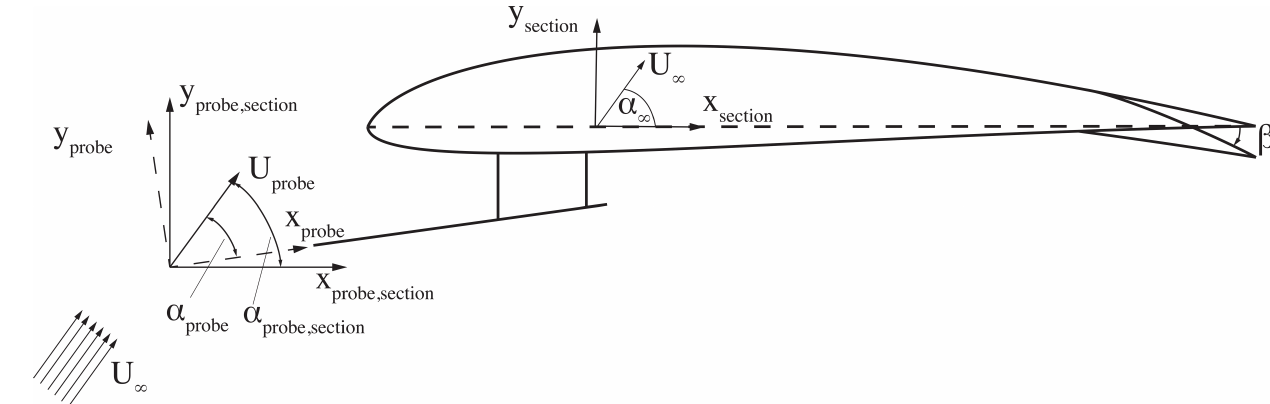
Figure 8. Sketch for the estimation of angle of attack and velocity from three-hole probe measurements (adapted from Klein et al., 2017).